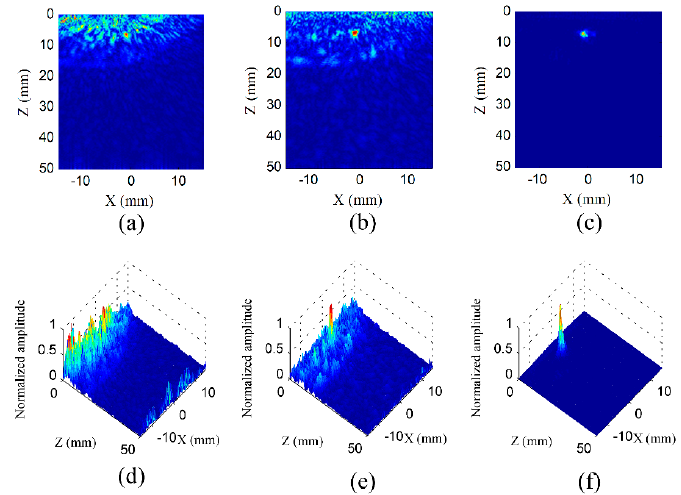
Figure 7. The images for specimen 1: ( a , d ) TFM with conventional full matrix; ( b , e ) TFM with hybrid full matrix; ( c , f ) sign coherence factor (SCF) with hybrid full matrix.